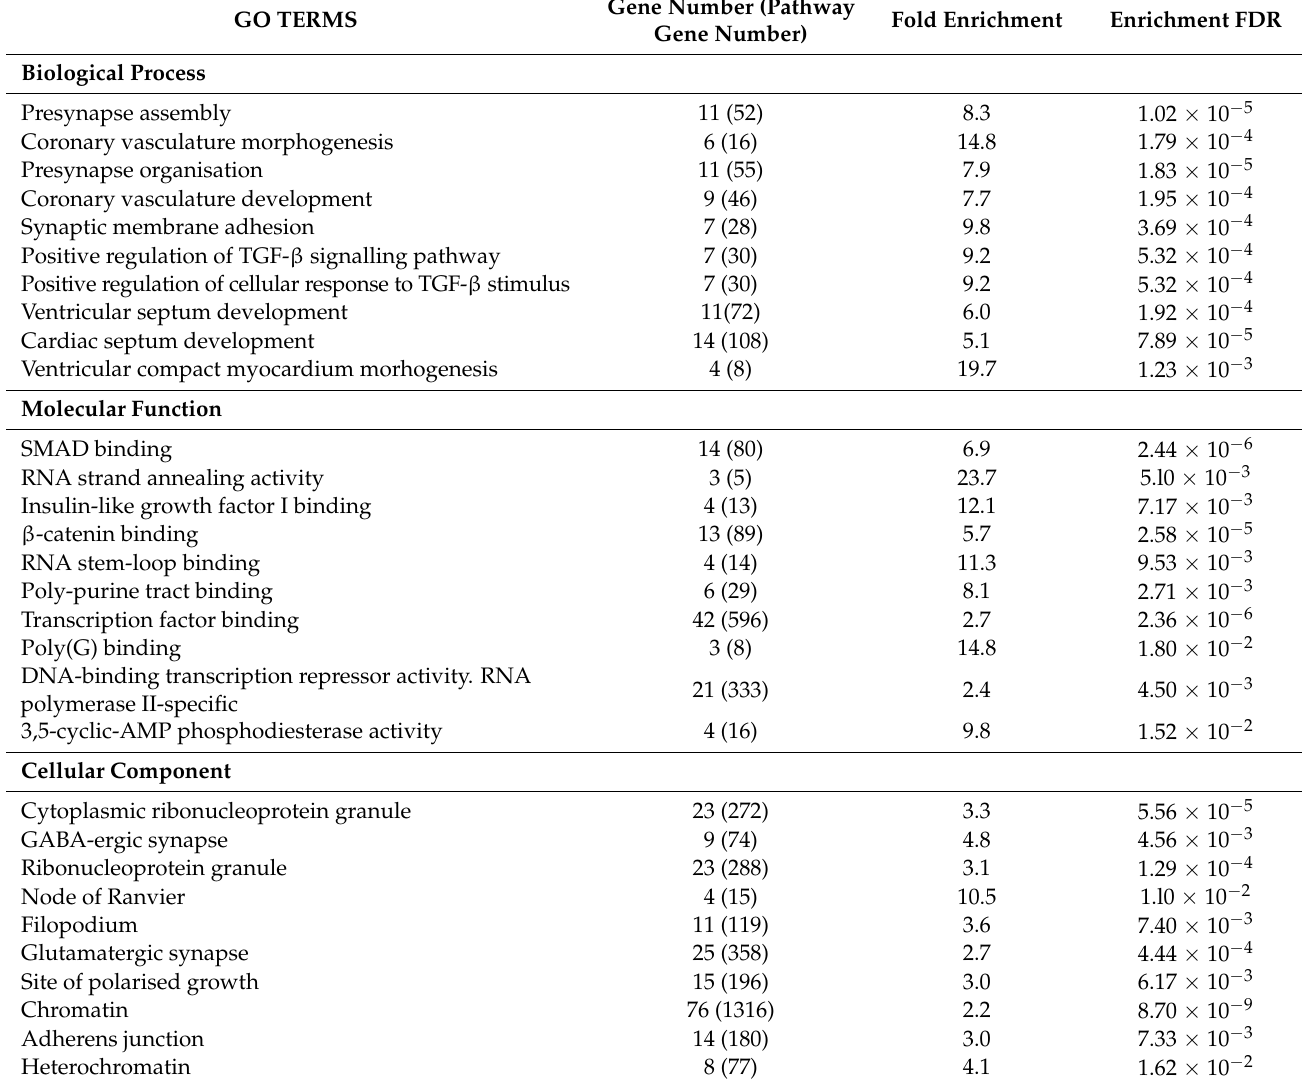
Table 1. Pathway enrichment analysis of GO terms in ShinyGo, sorted by average ranks (FDR and